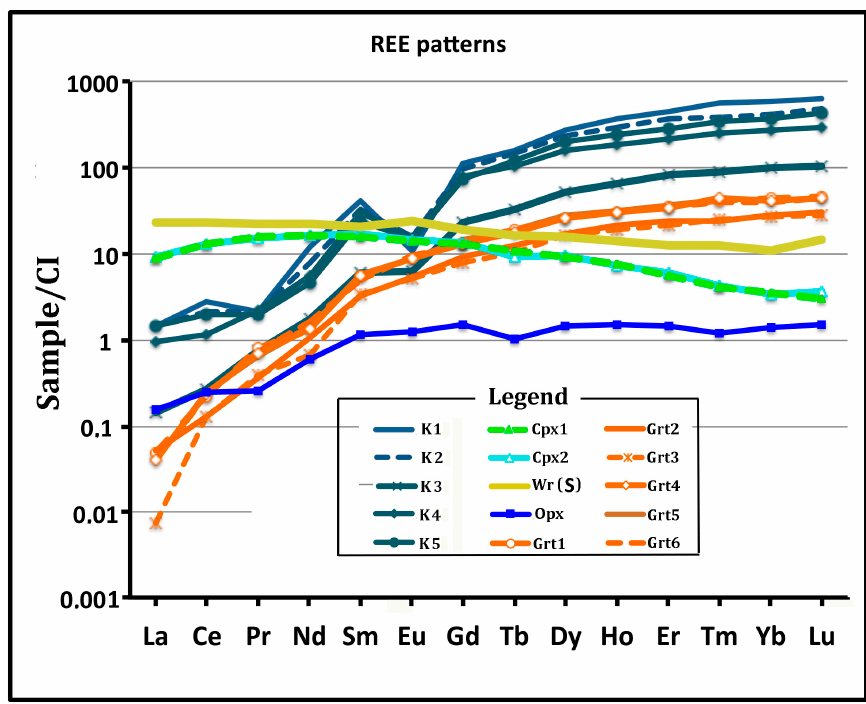
Figure 6. CI-normalized [49] rare earth element (REE )patterns of the sample whole rock (Wr-S) and therein garnet (Grt1–Grt6), Kelyphite (K1–K5), Calcic pyroxene (Cpx1 and Cpx2) and Ca-poor pyroxene (Opx). Numbers correspond to spot analyses as indicated in Figure 4a.